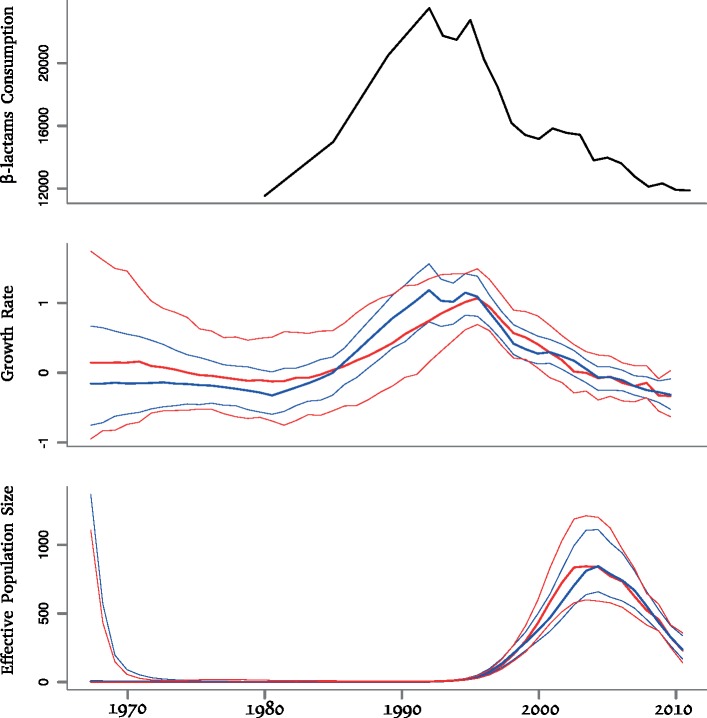
Results on the USA300 application. Top: covariate data, representing the consumption of \documentclass[12pt]{minimal}
\usepackage{amsmath}
\usepackage{wasysym}
\usepackage{amsfonts}
\usepackage{amssymb}
\usepackage{amsbsy}
\usepackage{upgreek}
\usepackage{mathrsfs}
\setlength{\oddsidemargin}{-69pt}
\begin{document}
}{}$\beta$\end{document}-lactams between 1980 to 2012 in the USA, measured in standard units per 1000 population. Middle: growth rate estimates. Bottom: effective population size estimates. The middle and bottom plots show results without (red) and with (blue) the use of the covariate data, and with a solid line indicating posterior means and shaded areas indicating the 95% credible regions.